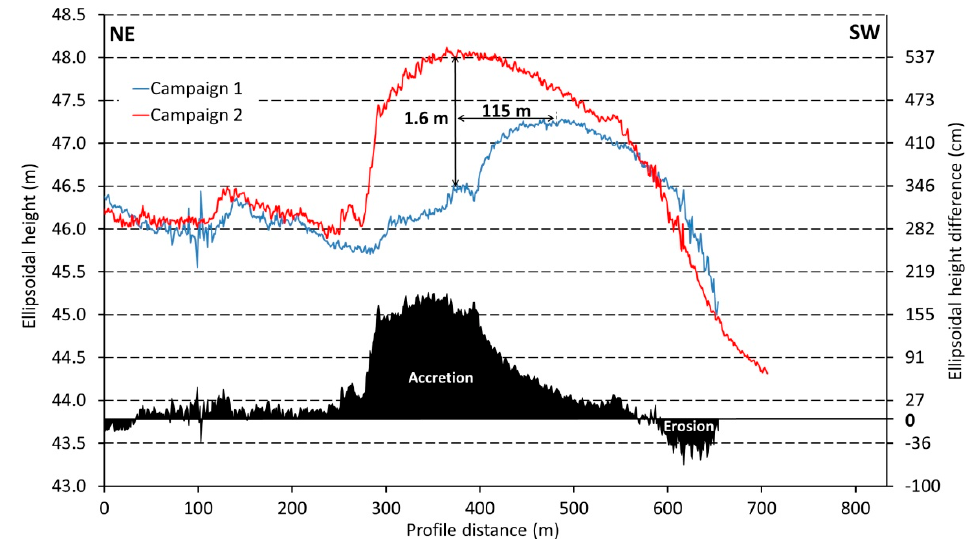
Figure 13. Ellipsoidal height profiles, extracted from the DSM of campaigns 1 (blue) and 2 (red) and difference between both (black).